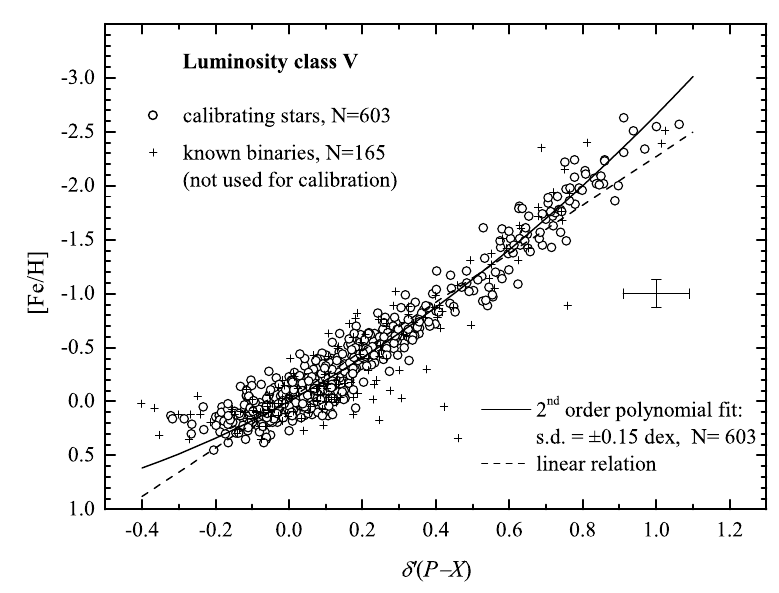
Fig. 5a. (cid:14) ′ ( P – X ) vs. [Fe/H] relation for calibrating dwarf stars with metallicities from high-dispersion spectroscopy. The solid line is a second-order polynomial fit and the dashed line is a linear relation. Known spectroscopic binaries are plotted for comparison.